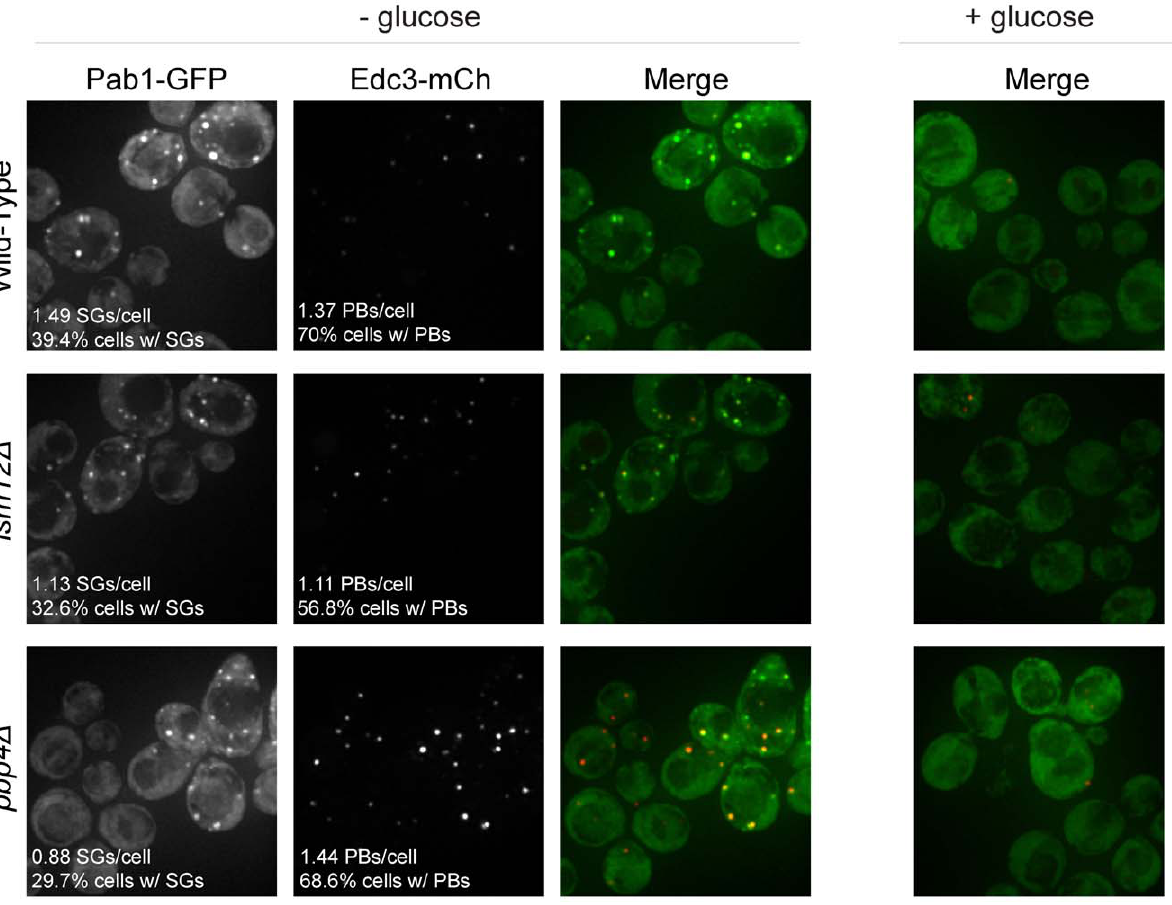
Figure 3. Lsm12 and Pbp4 are not required for stress granule formation. lsm12 D , pbp4 D , and wild-type strains were transformed with a plasmid containing Edc3-mCherry (P-body marker) and Pab1-GFP (stress granule marker) and assessed for the ability to form either granule following ten minutes of glucose deprivation stress. (SGs denotes stress granules; PBs denotes P-bodies.)